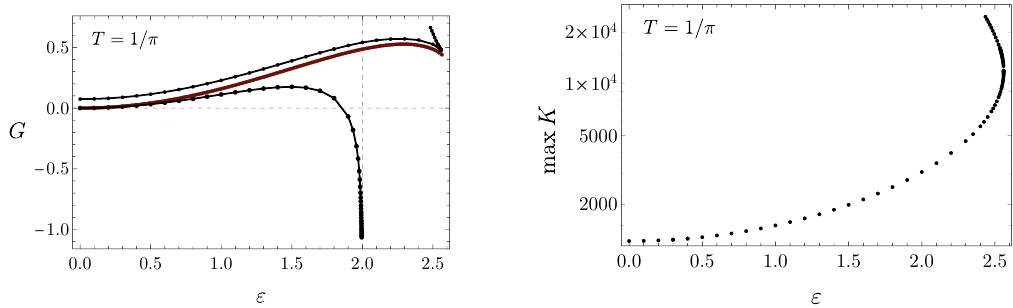
Figure 23 . Left : Gibbs free energy against the boundary pro(cid:12)le for black holes with a (cid:12)xed temperature T = 1 =(cid:25) (black disks), and soliton (brown squares). The dashed gridline marks the " ! 2 limit. Right : maximum of the Kretschmann invariant against " for the small black hole with a (cid:12)xed temperature. As max K increases, the K looks very similar to that of the soliton.